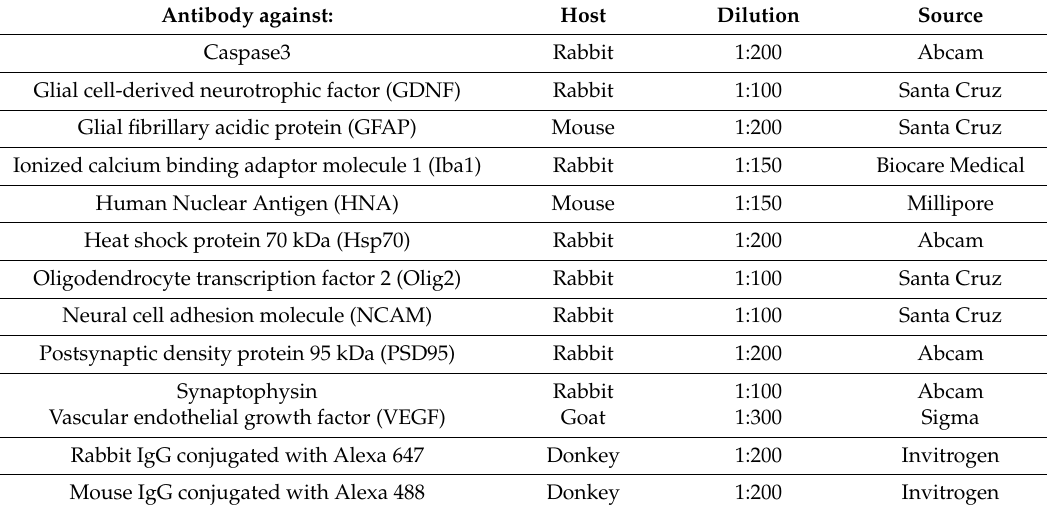
Table 2. Antibodies used in immunofluorescent